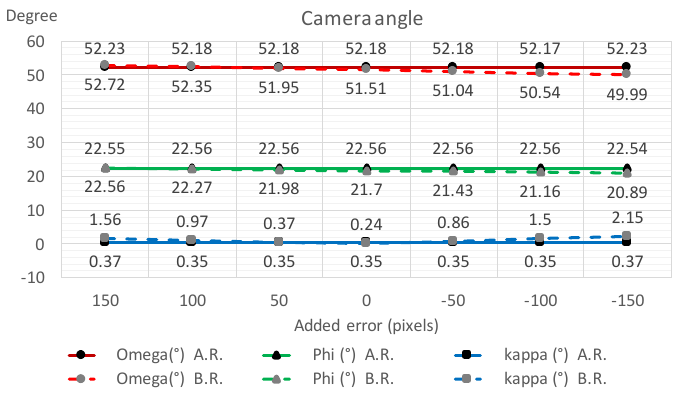
Figure 12. Camera angle estimation with and without the vanishing point refinement process with different manually added errors on V x .